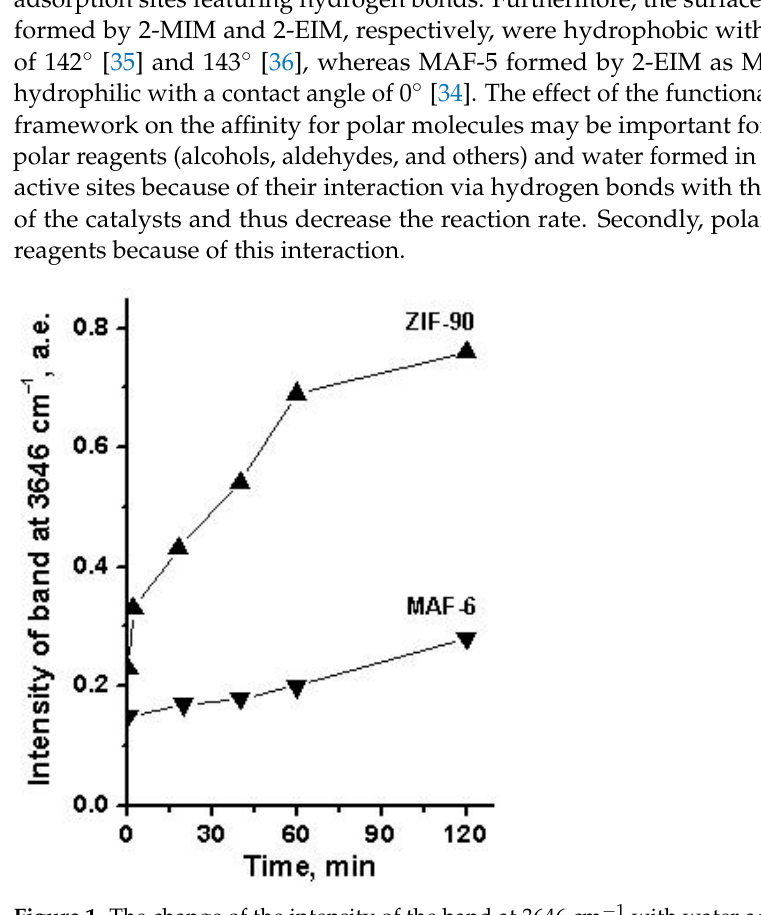
Figure 1. The change of the intensity of the band at 3646 cm − 1 with water adsorption on ZIF ‐ 90 and MAF ‐ 6, and IR spectra of MAF ‐ 6 and ZIF ‐ 90 activated under vacuum at 423 K for 3 h and after the addition of wet air at room